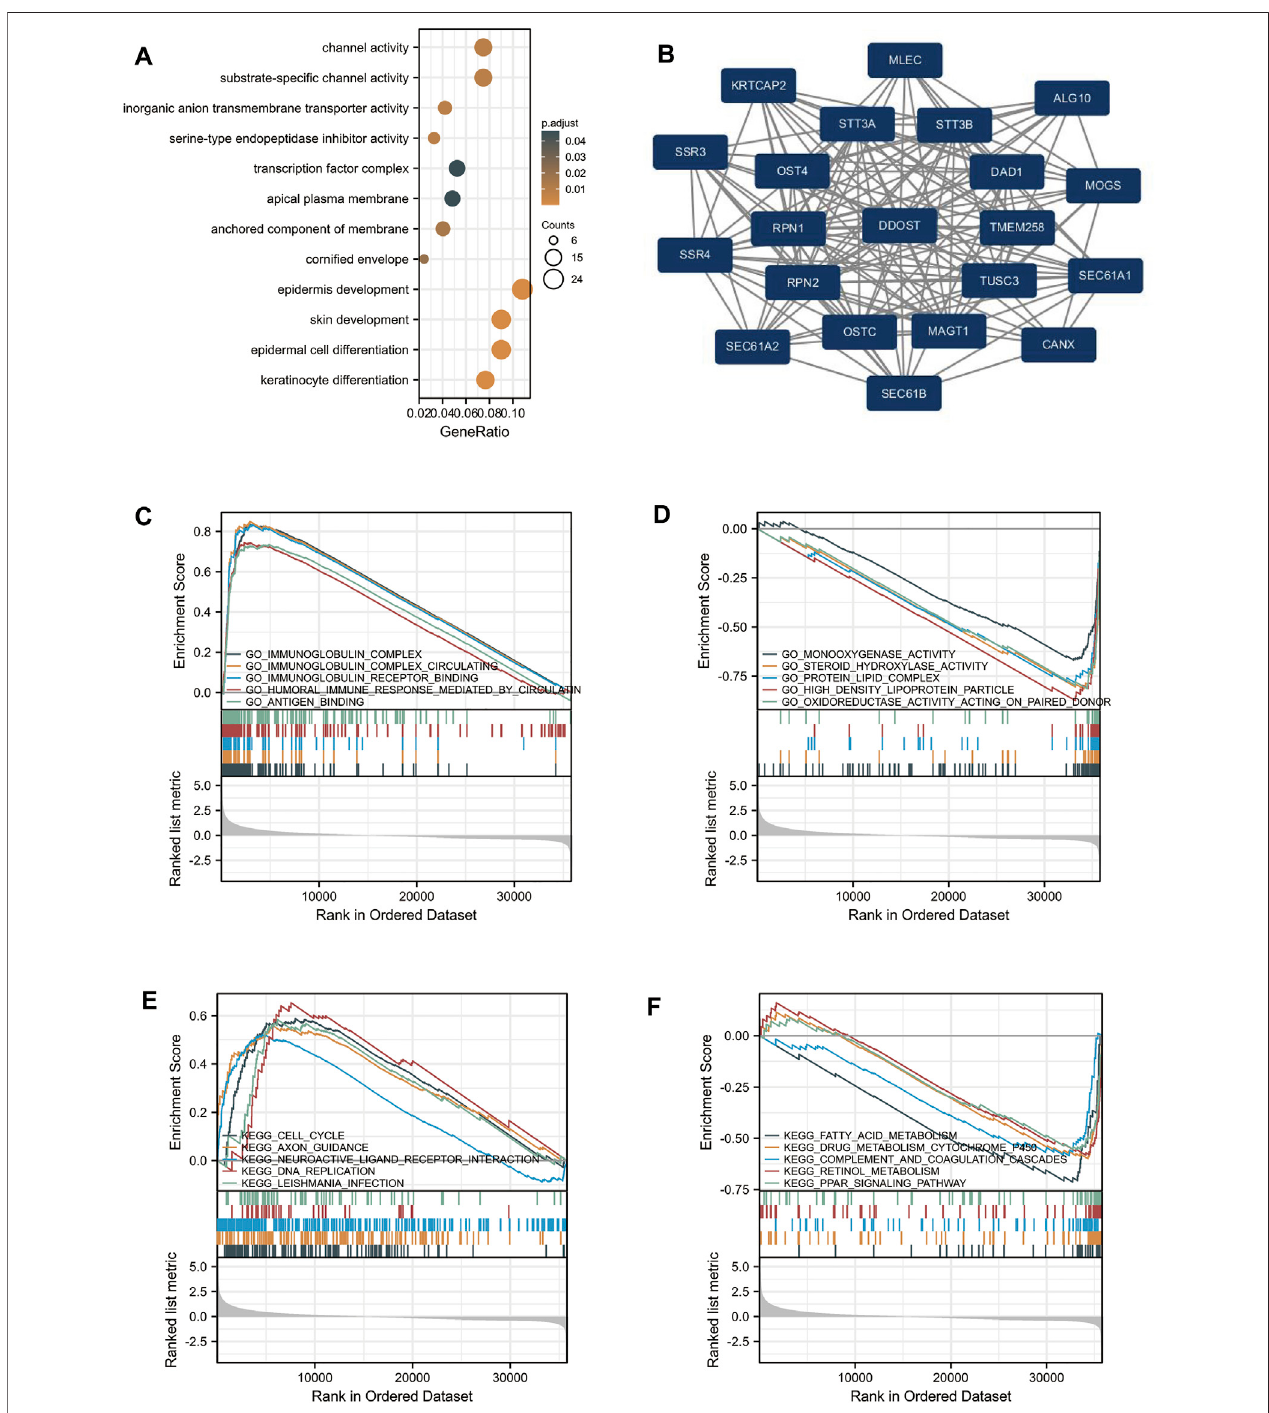
FIGURE 2 | Enrichment analysis of DDOST in HCC. (A) Biological process enrichment related to DDOST-related genes. (B) A network of DDOST and its 20 potential co-interaction proteins. (C – F) The results of enrichment analysis from GSEA.